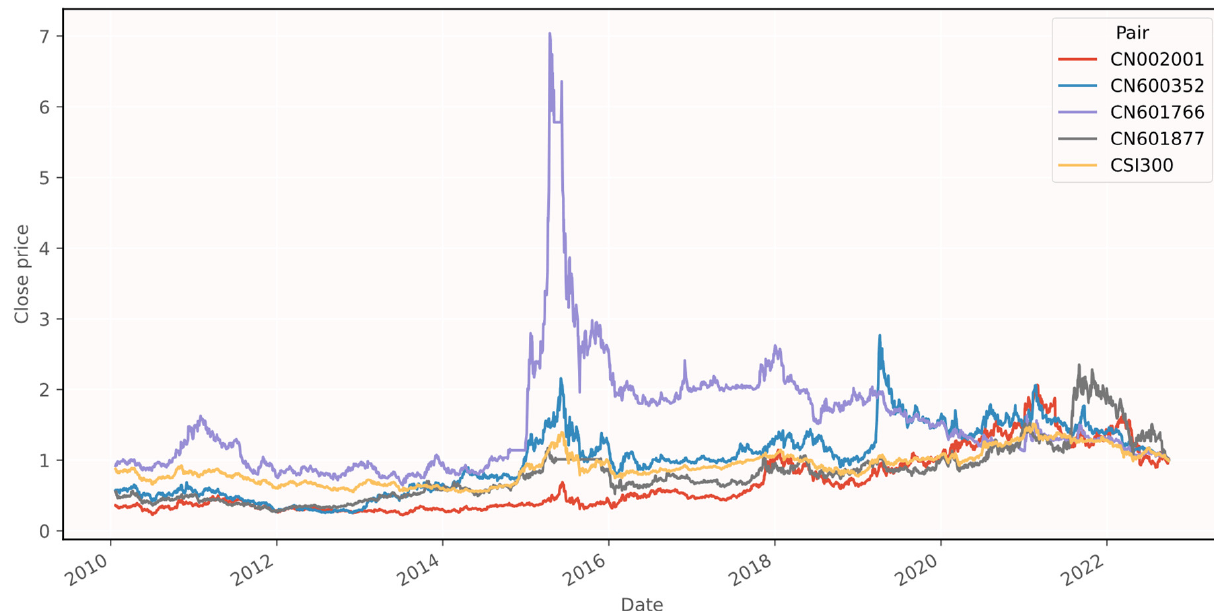
Figure 7. The closing price changes of Portfolio 3.